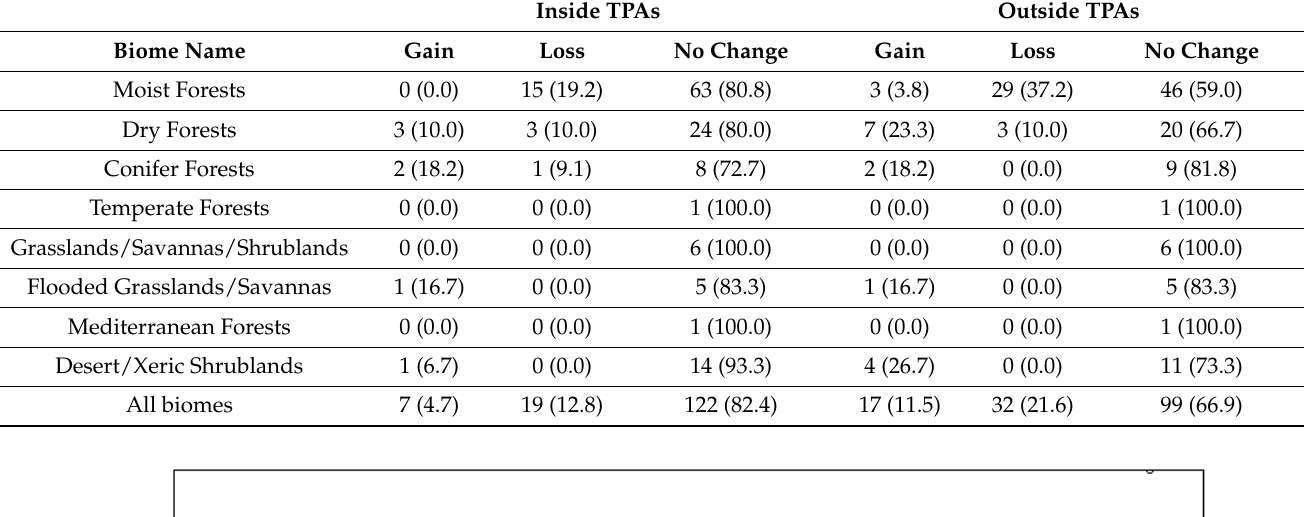
Table 6. Number (percentage) of ecoregions within each biome that had significant ( p ≤ 0.10) gains or losses in woody vegetation from 2001 to 2010 inside and outside of TPAs. Ecoregions and biomes with <10% total woody cover were removed from the analysis, leaving 148 ecoregions.